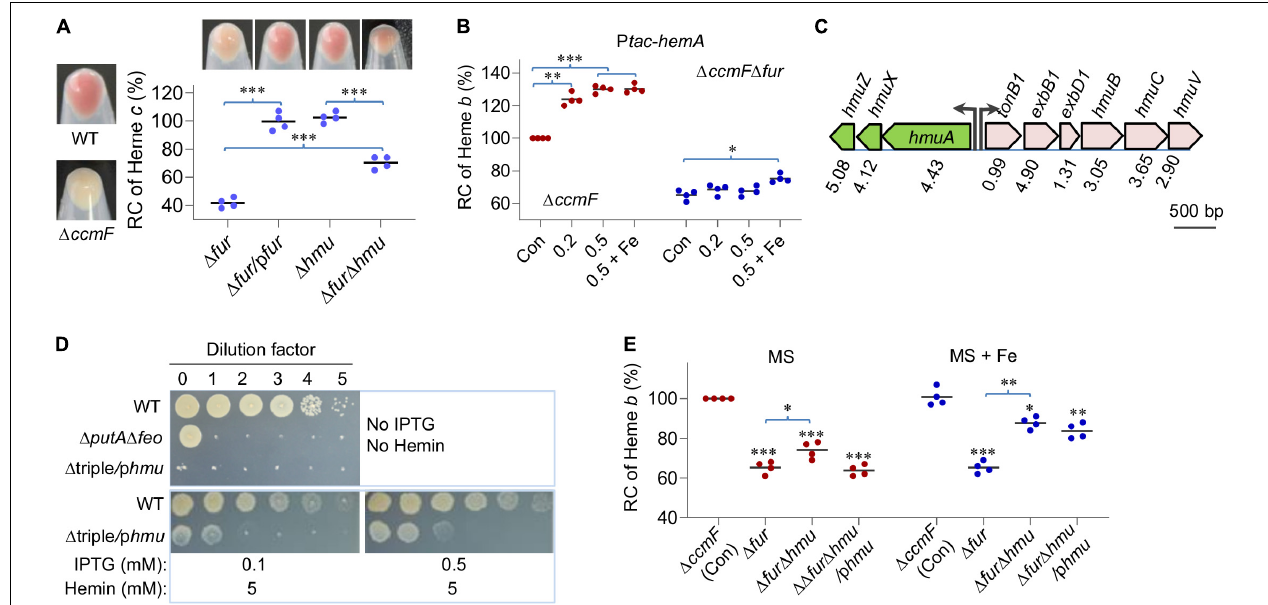
FIGURE 4 | The Fur loss down-regulates heme b levels by accelerating heme degradation. (A) Heme c levels in relevant strains. Cultures of indicated strains entering the stationary phase were pelleted, photographed, and lysed for quantification of heme c levels. (cid:49) hmu , (cid:49) hmuAXZ . RC, relative concentration. The average heme c levels in WT and (cid:49) ccmF was set to 100% and 0%, respectively. Asterisks indicate statistically significant differences between values linked by bracket (* P < 0.05; ** P < 0.01; *** P < 0.001). (B) Effects of HemA overproduction on heme b levels. Overproduction was driven by the IPTG-inducible P tac promoter (P tac-hemA ) with IPTG at indicated concentrations. Cyt c -deficient strains ( (cid:49) ccmF ) were used to avoid the interference of heme c , whose heme b level was set to 100%. Con, carrying empty vector. +Fe, supplemented with 0.2 mM FeCl 3 . Asterisks indicate statistically significant difference of the value compared to that of the respective Con. (C) The gene organization of heme uptake and utilization in S. oneidensis . Proteomic data were shown as the ratio of abundance in (cid:49) fur to WT. (D) HmuRSO is essential for heme utilization revealed by droplet assays. (cid:49) triple, (cid:49) putA (cid:49) feo (cid:49) hmu; p hmu, p hmuAXZ driven by P tac. (E) Effects of hmuAXZ deletion on heme b levels as assayed as in (B) . Experiments were performed at least three times, and data were presented as means ± SEM or as values representative of similar